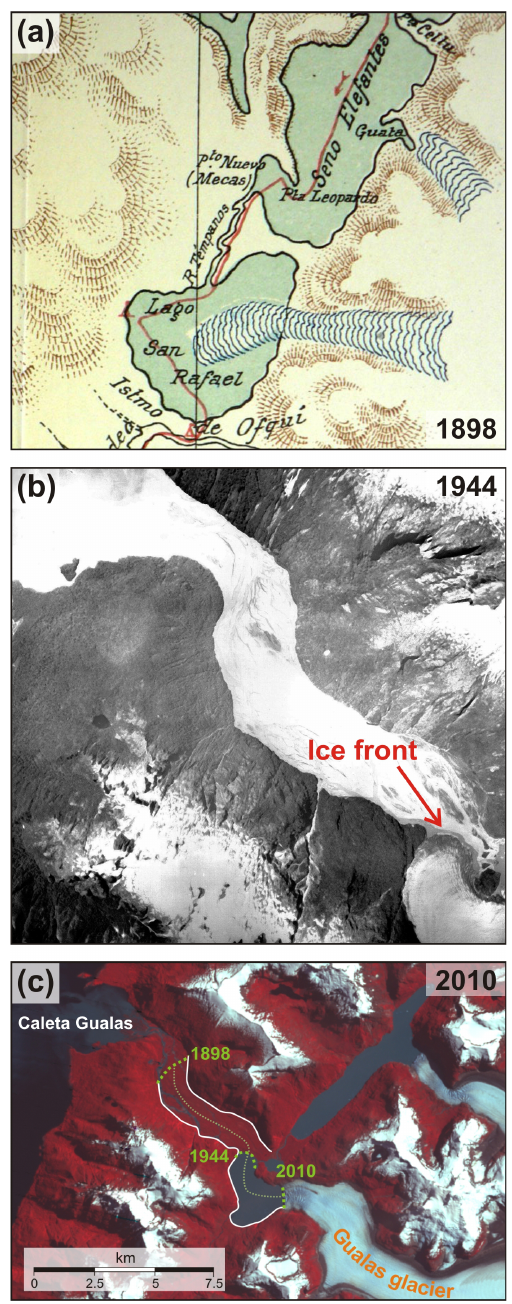
Fig. 6. Historical positions of Gualas glacier. (a) Map of Stef- fen (1910), summarizing his observations of 1898. (b) Aerial pho- tograph of Trimetrogon flight in 1944. (c) False color Landsat 2010 image, with indications of the ice front position of Gualas glacier in 2010, 1944 and 1898, according to (a) and (b) . The white line delimits Gualas glacier valley and it was used to calculate the sur- face area loss. The dashed line represents the central path of Gualas glacier, as it was used to calculate length